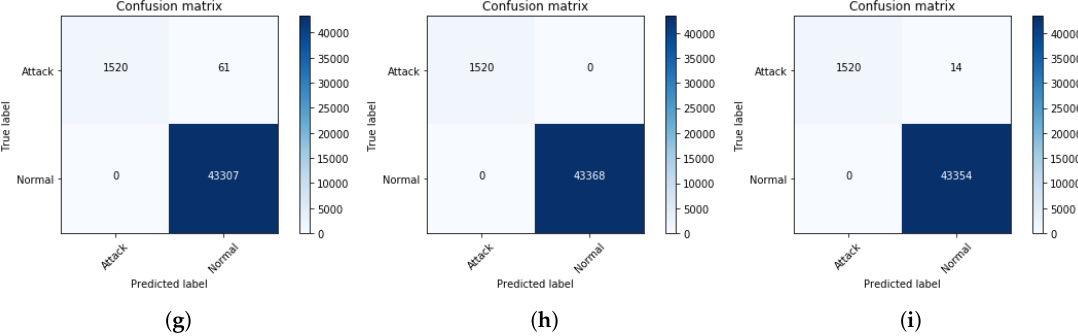
Figure 15. Confusion matrix results of three approach models RNN, LSTM, and GRU on ISCX selected feature subset. ( a – c ) on Tuesday, ( d – f ) on Wednesday, ( g – i ) on Thursday.